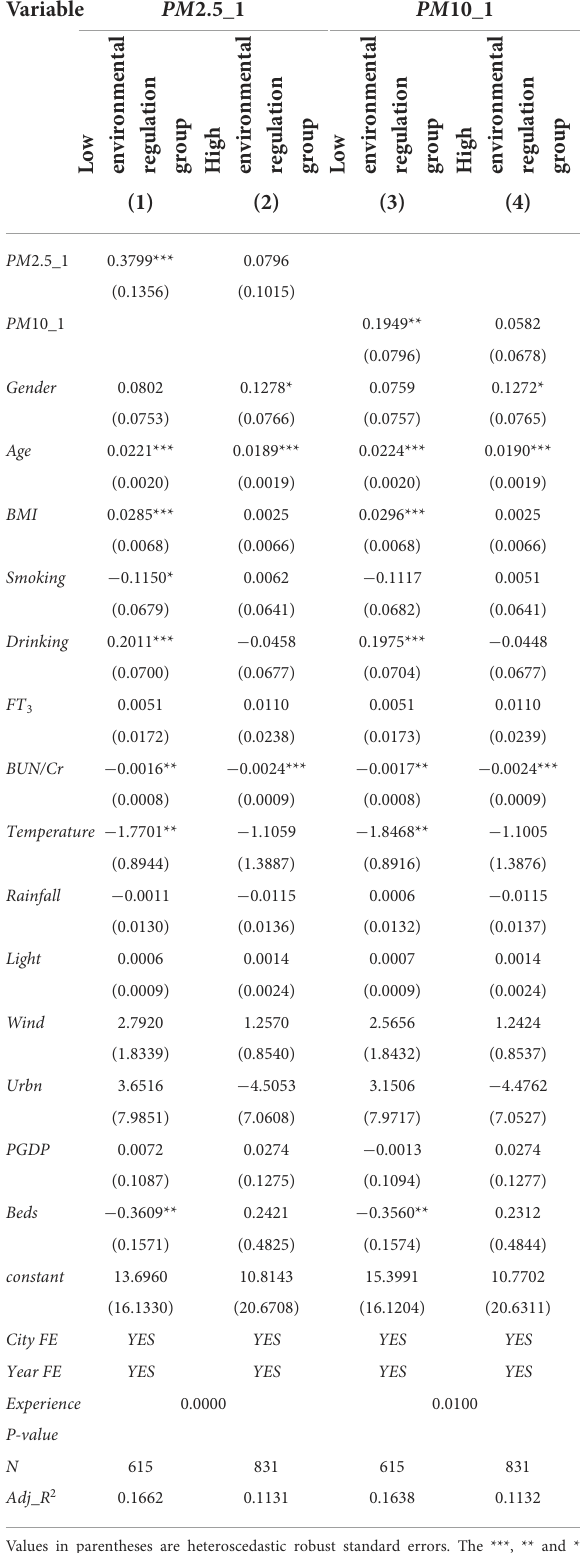
TABLE 7 Heterogeneity analysis of environmental